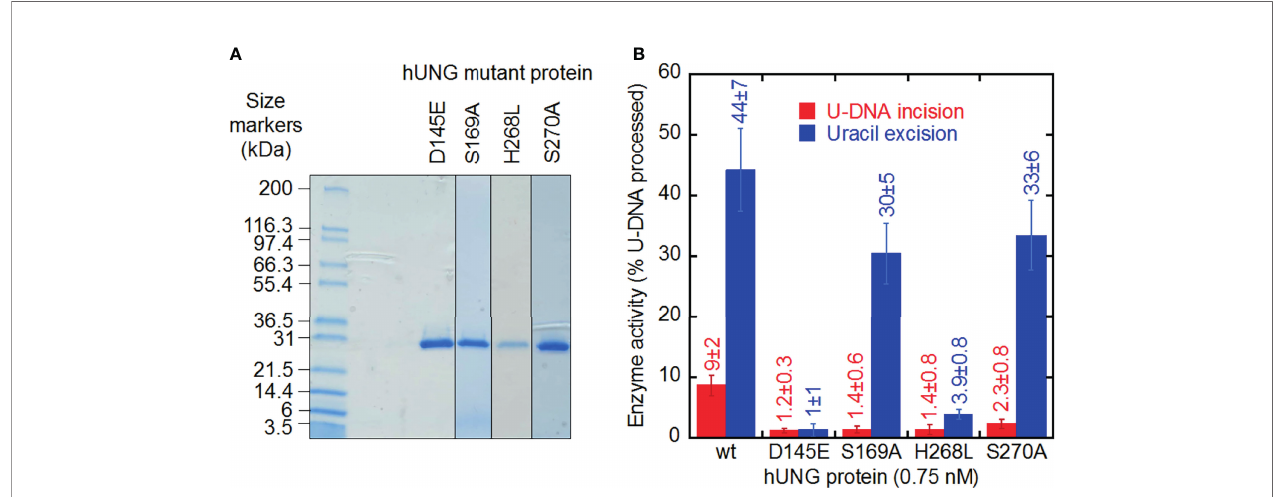
FIGURE 3 | U-DNA incision and uracil excision activity of hUNG mutant proteins puri fi ed to apparent physical homogeneity. (A) SDS-PAGE of puri fi ed proteins stained with Coomassie Blue. Samples (20 µl; treated 5 min at 95°C in NuPAGE ® LDS Sample Buffer, Cat. No. NP0007, Life Technologies) and protein markers (Mark12 ™ Unstained Standard, Cat. No. LC5677, Life Technologies) were run on a 4 – 20% Mini-PROTEAN ® TGX ™ Precast Gel (12 wells; Bio-Rad) in 25 mM Tris, 0.192 M glycine, 0.1% (w/v) SDS at 200 V for 35 min. Left lane, protein markers; right lanes, hUNG mutant proteins. (B) Different decrease in U-DNA incision and uracil excision activity by site-directed mutant hUNG proteins. Wild-type and mutant proteins (0.015 pmol) were incubated with S1 (10 pmol) at 37°C for 20 min (see Figure 1A ). Each value represents the average ± SD of 5 – 16 independent